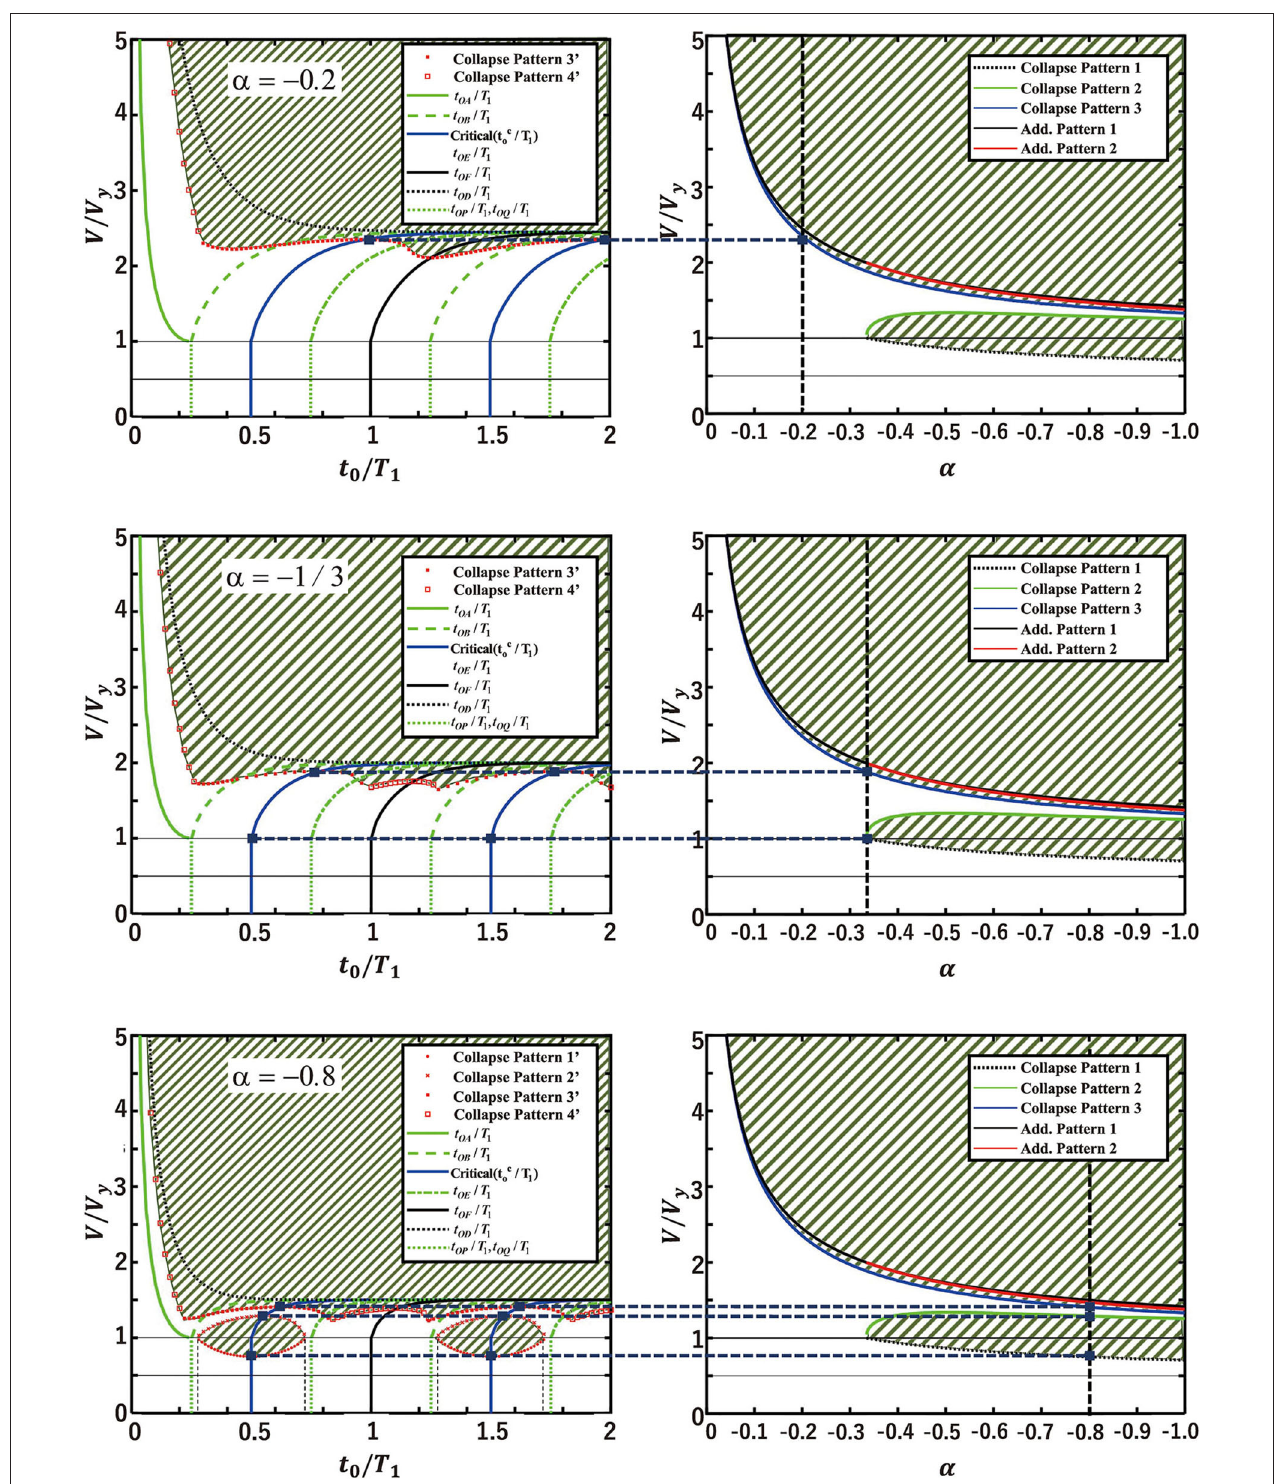
FIGURE 13 | Collapse limit input velocity of double impulse with arbitrary interval for SDOF system with various negative post-yield slopes ( α